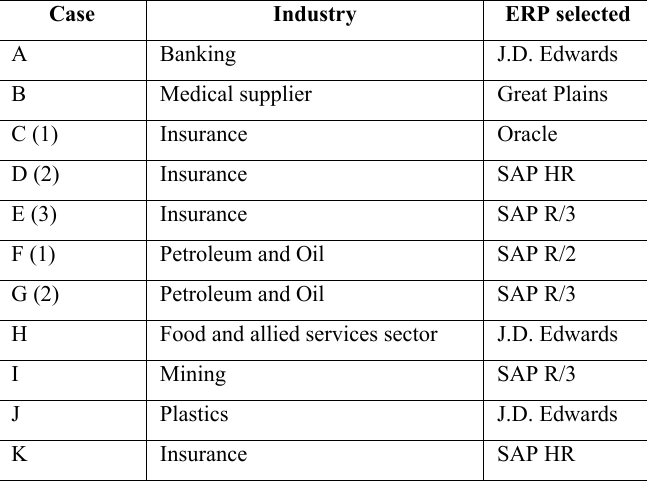
Table 2: Industry and ERP selected by case